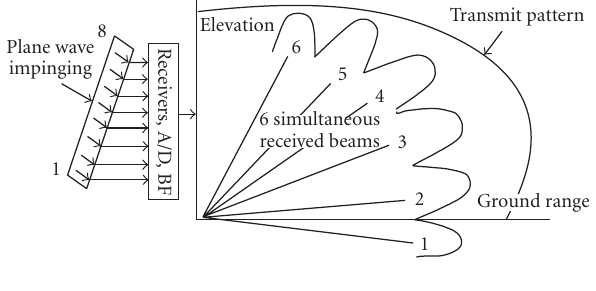
Figure 5: Multibeam receive